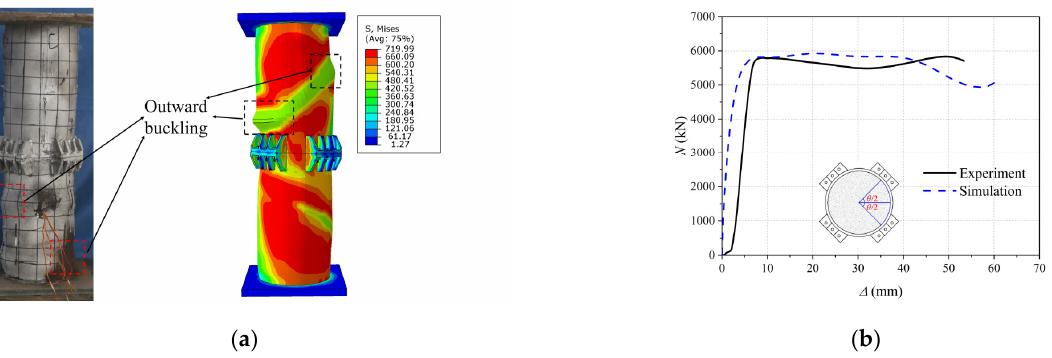
Figure 21. Comparison between experiment and simulation of BWCFST short column with θ of 90 ◦ : ( a ) Failure mode; ( b ) N - ∆ curve.